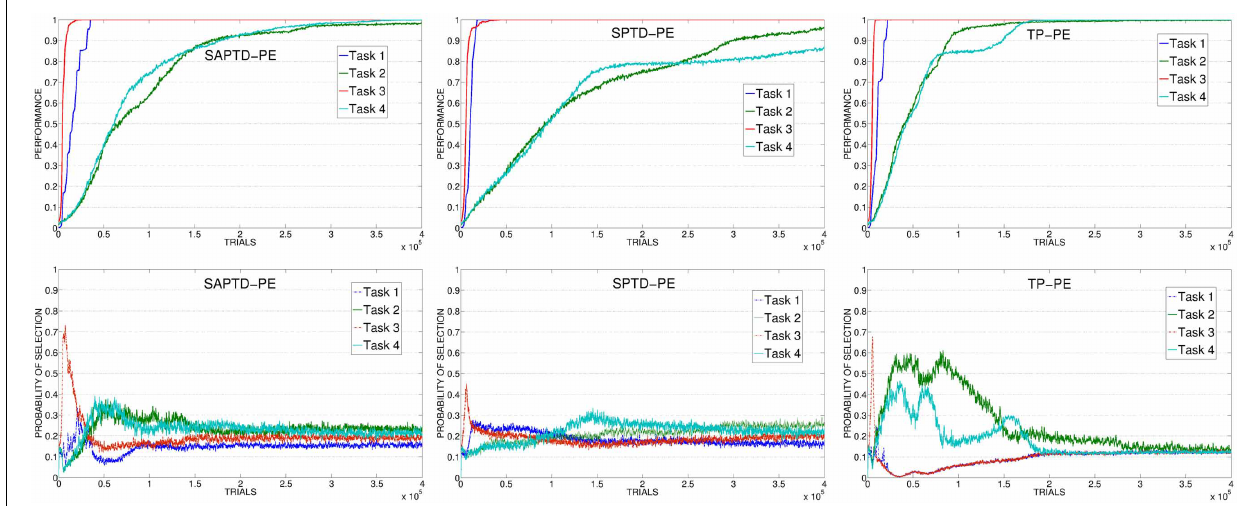
FIGURE 8 | Top: Average performance on the 4 learnable tasks in the best condition (with respect to the learning rate of the predictor) of SAP-TD-PE, SP-TD-PE, TP-PE. Bottom: Average selection probability for the experts associated to the 4 learnable tasks, in the same conditions.